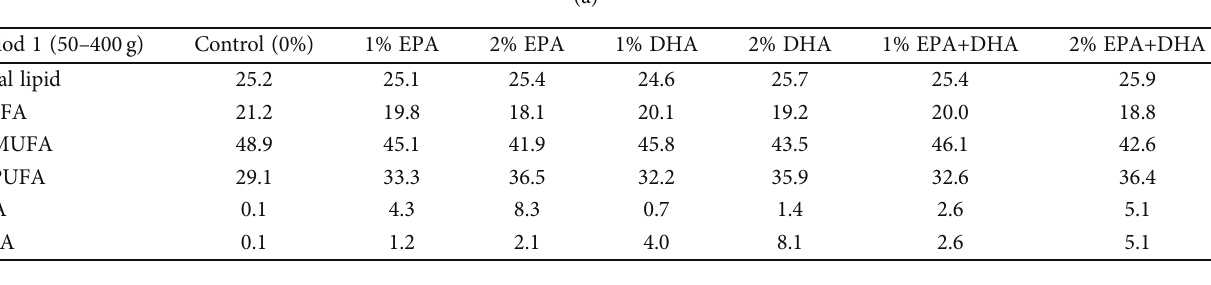
Table 1: Fat composition (% of total fat) in the experimental diets in periods 1 and